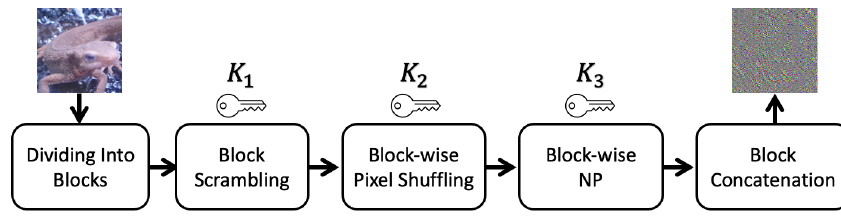
Figure 2. Pipeline of proposed encryption